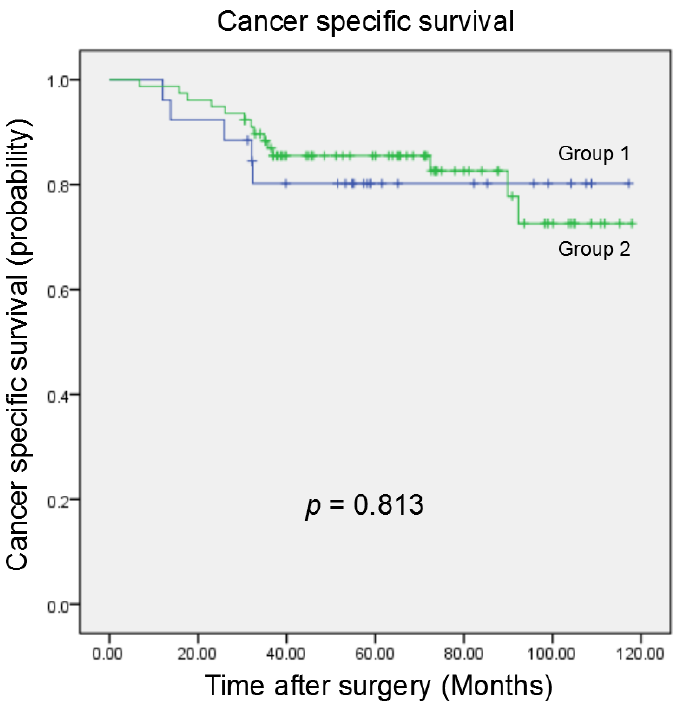
Figure 8. Survival outcomes: The Kaplan–Meier estimation showed no statistical difference in the cancer-specific survival (CSS) rate between the lobe-specific lymph node dissection (L-SND) and SND